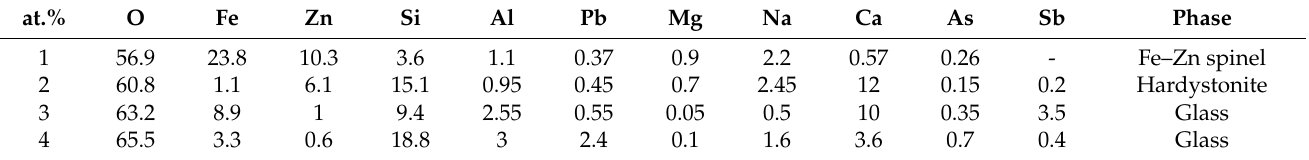
Figure 14. EDS mapping of slag 2 particles sintered at 1100 °C.